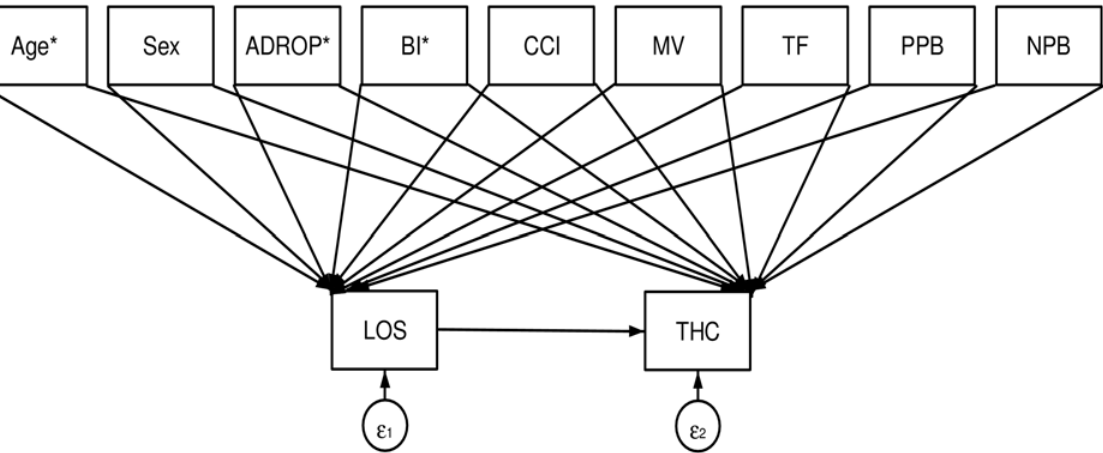
Fig 2. A path showing the relationship between each variable using structural equation modeling. Abbreviations: BI, Barthel index; CCI, Charlson comorbidity index; MV, Mechanical ventilator; TF, Tube feeding; PPB, Physicians per beds; NPB, Nurses per beds; LOS, Length of stay; THC, Total hospitalization costs; ε ; error term * Age, ADROP scores, Barthel index and Charlson comorbidity index include dummy variables in each